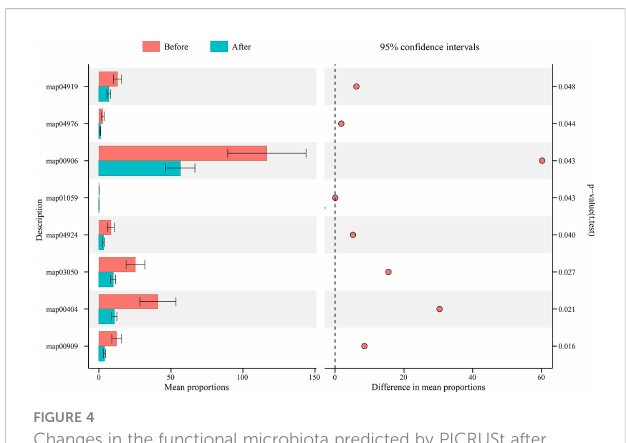
FIGURE 4 Changes in the functional microbiota predicted by PICRUSt after applying the postbiotic gel. Eight signi fi cant differential KEGG pathways (t-test; P < 0.05) were identi fi ed before (shown in red) and after (shown in blue) applying the postbiotic